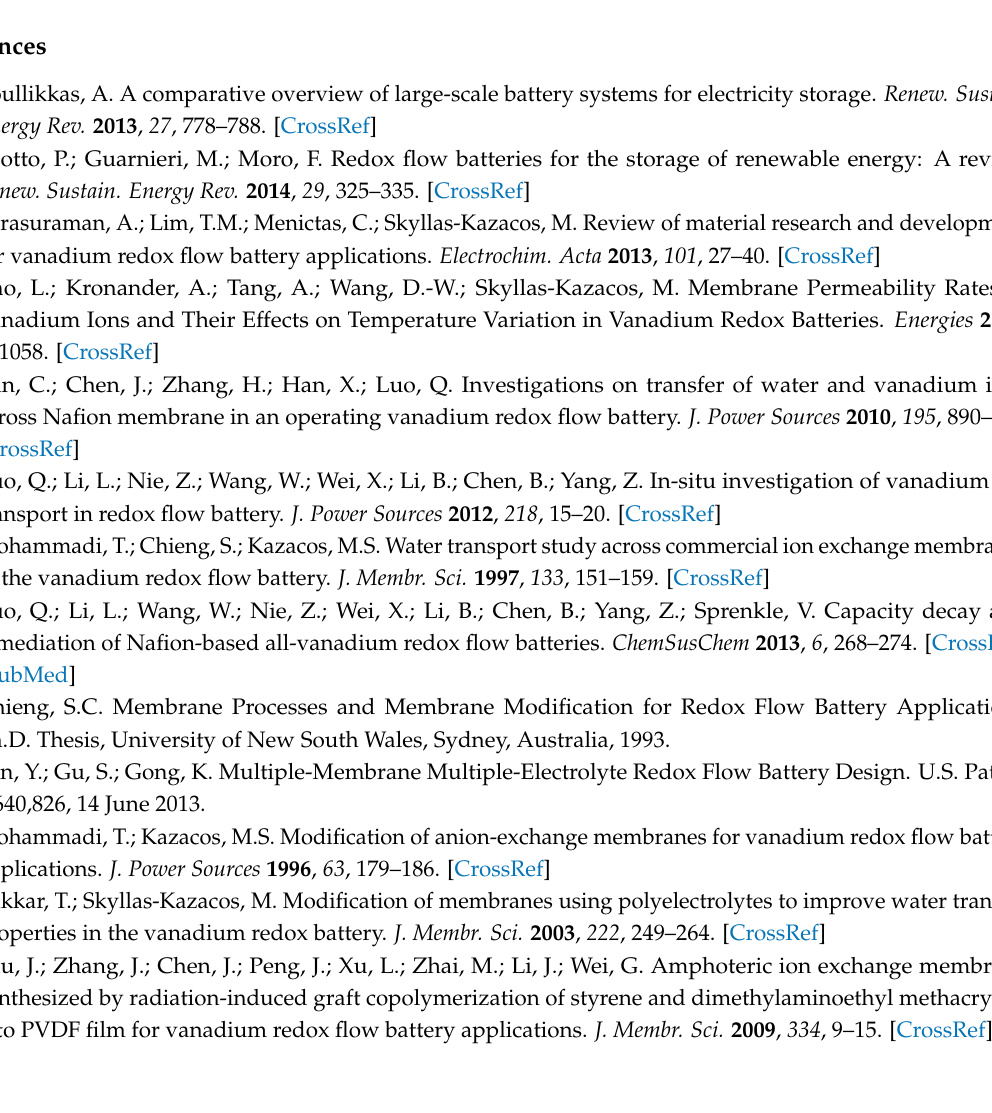
and CEM. Figure S2: Charging and discharging capacity over 125 cycles after auto-rebalancing of a 2-cell stack assembled with a combination of AEM and